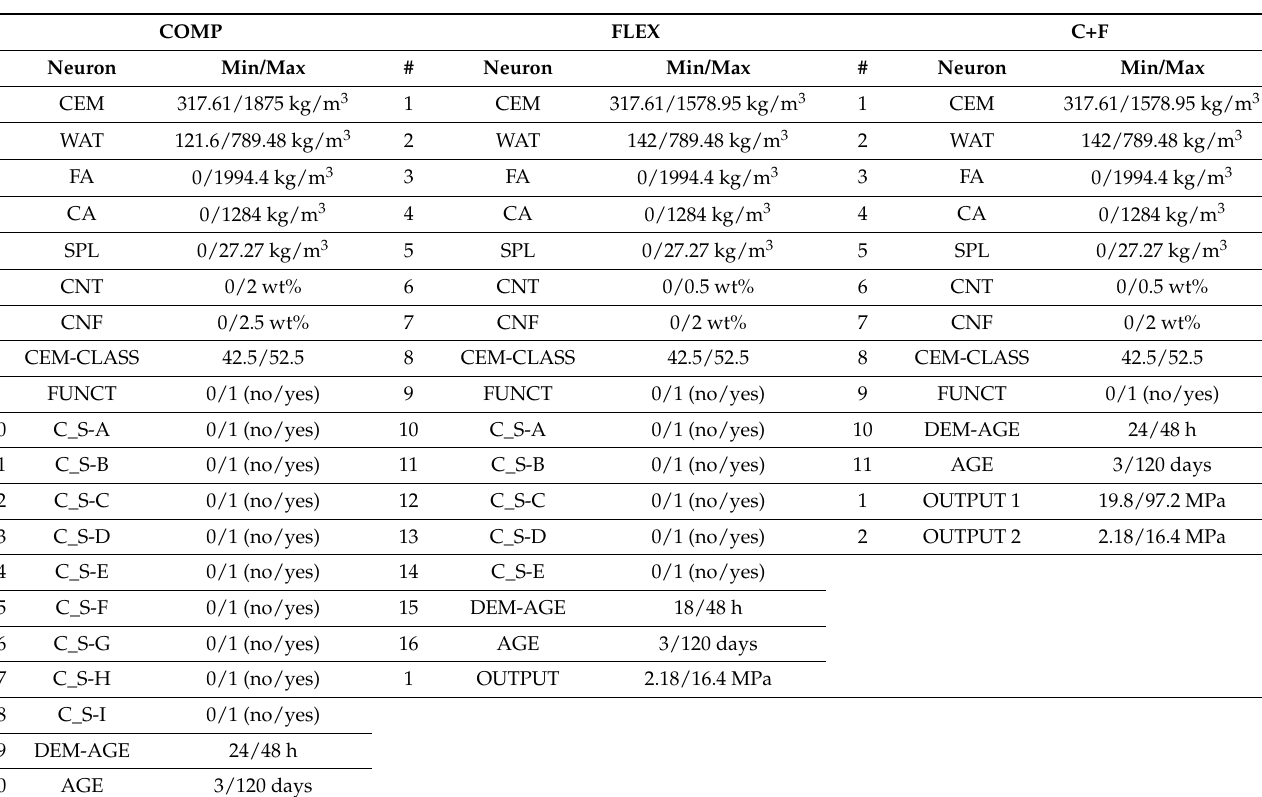
Table 5. Input neurons for each dataset and their minimum/maximum